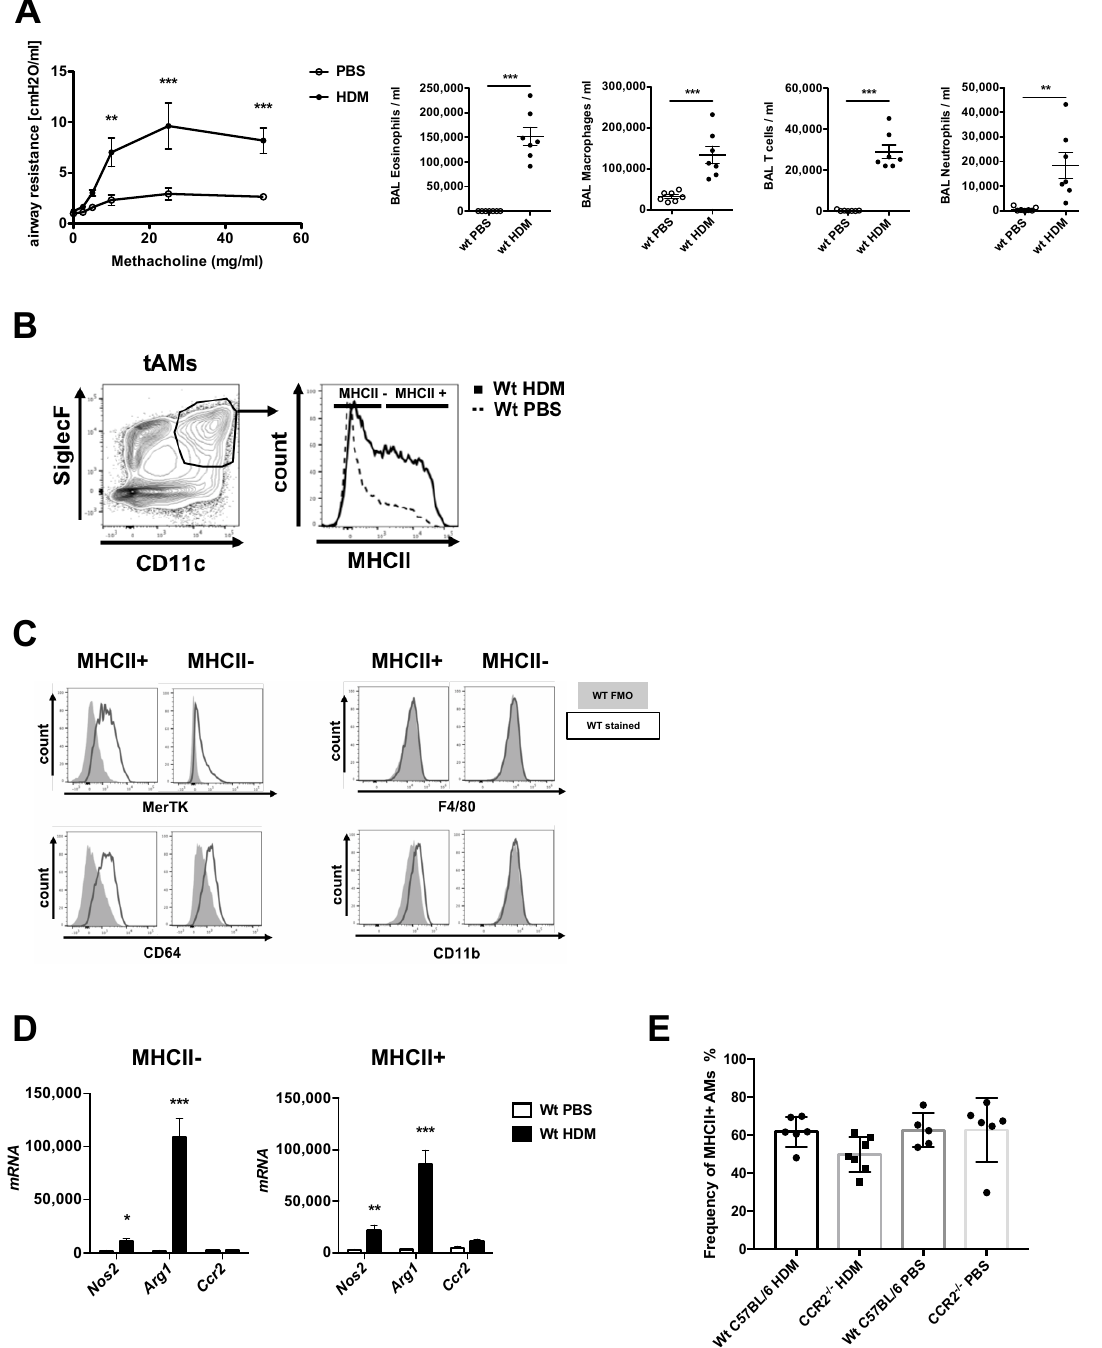
Figure 1. Allergic asthmatic inflammatory conditions drive a heterogenous expression of MHCII in tissue resident alveolar macrophages. ( A ) Characterization of the allergic asthma phenotype of mice